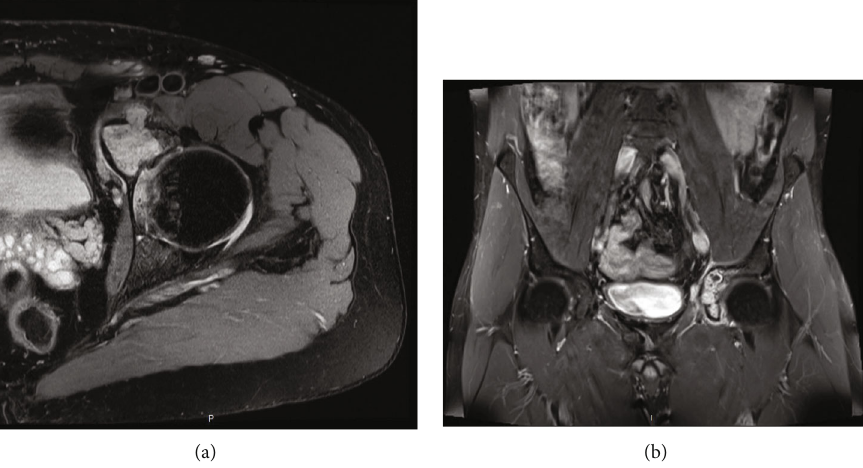
Figure 12: Axial (a) and coronal (b) T1 TSE sequence views on initial MRI of the pelvis showing a tumor of the left iliopubic ramus.